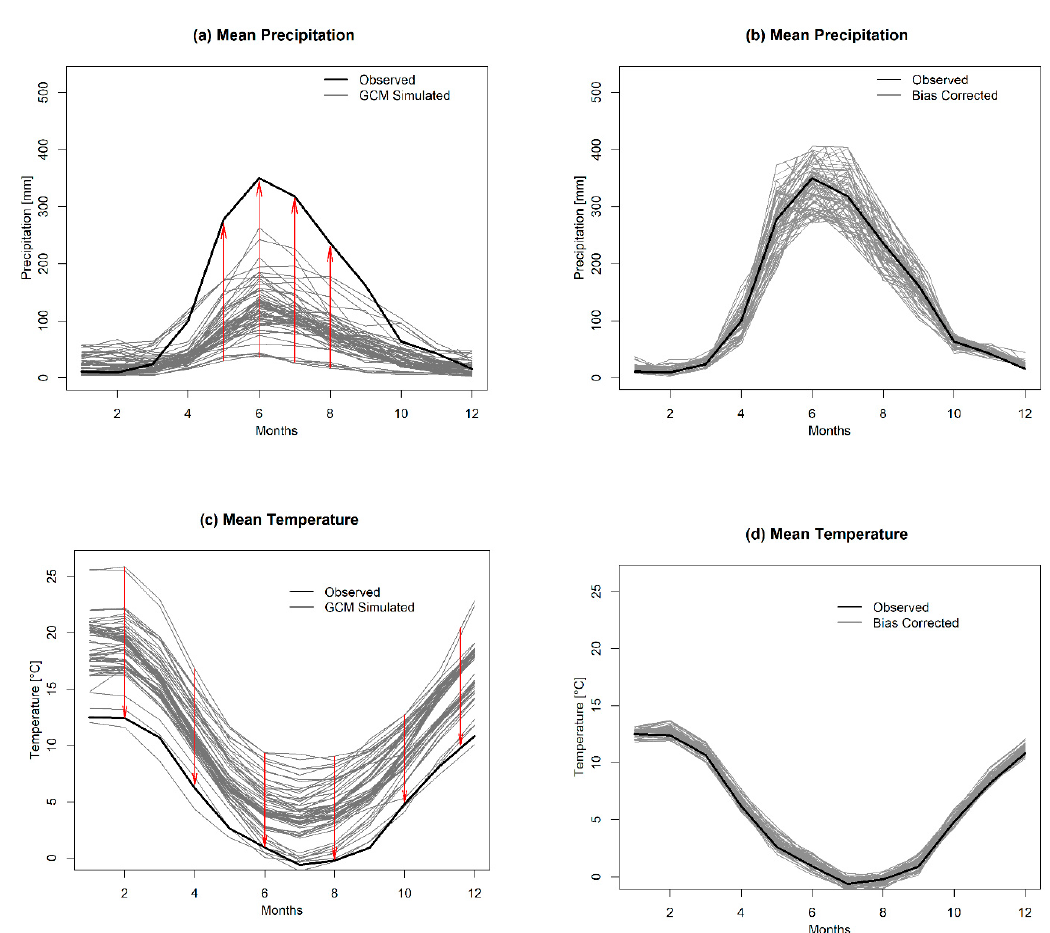
Figure 5. Statistical scaling results for precipitation and temperature, applied to the 70 GCM simulations used in this study; ( a , c ): Indicate the observed value curves in contrast to the values simulated by the GCMs. ( b , d ): Show the observed value curves along with the bias-corrected curves.